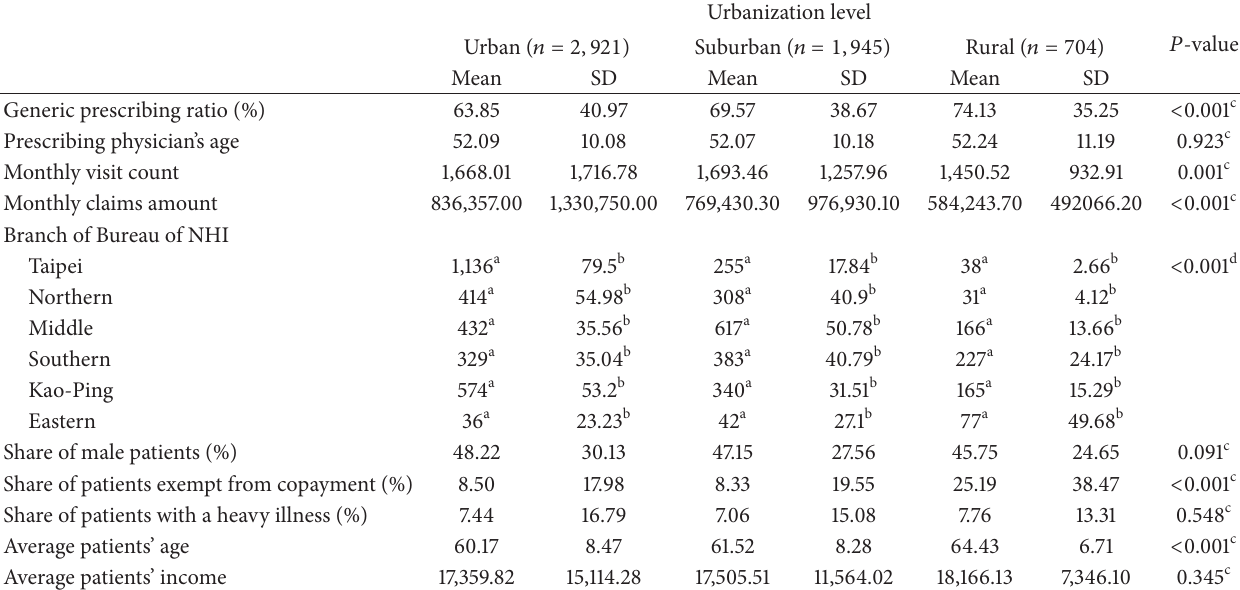
Table 3: Differences in generic prescribing ratio of DHP derivatives and other measures at physician clinics of various urbanization